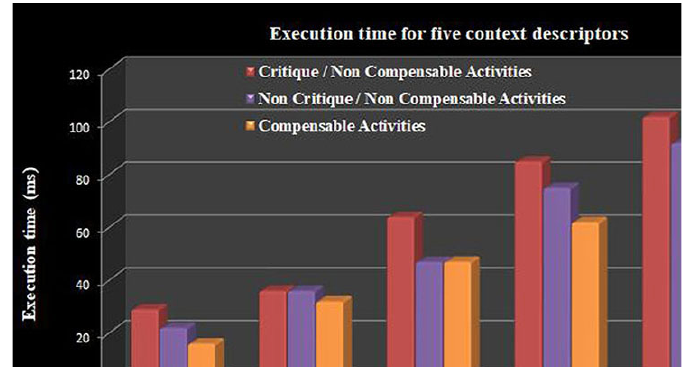
Fig. 7. Execution time for five context descriptors by varying the